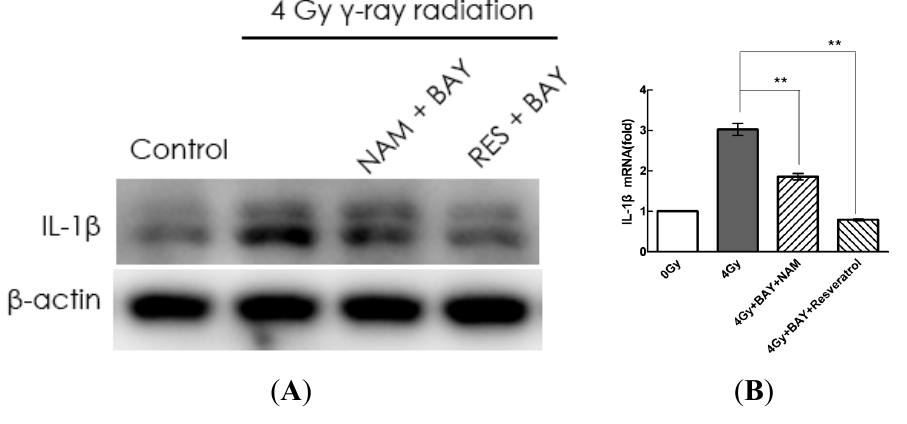
Figure 6. Sirt1 inhibits IL-1 β expression via the NF- κ b pathway in MSCs. ( A – C ) Cells were pre-treated with BAY (5 μ M) and either resveratrol (200 μ M) or NAM (20 mM) for 1 h prior to stimulation with radiation (4 Gy). Extracellular and intracellular protein and mRNA levels of IL-1 β were determined by ELISA, Western blot, and quantitative real-time PCR analyses, respectively. Values are presented as the mean ± SD ( n = 3). * p < 0.05, ** p < 0.01 compared with the radiation